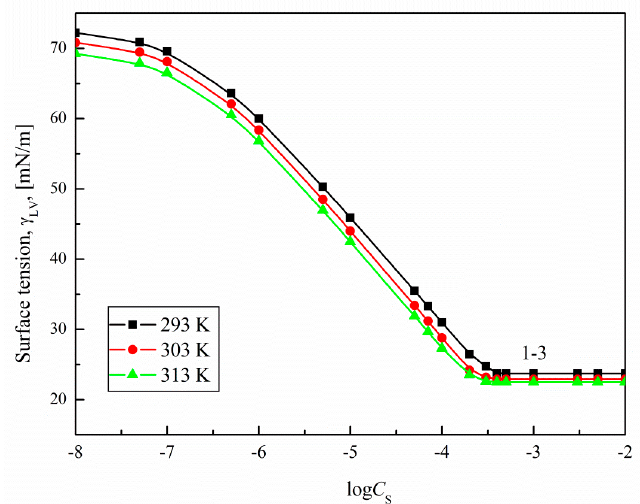
Figure 10. Measured values of surface tension ( γ LV ) of aqueous solutions of TS-OE12 (curves 1–3) at 298 K, 303 K and 313 K vs. the logarithm of surfactant concentration (log C S ). As follows from this figure, at all studied temperatures, the surface tension of the studied trisiloxane surfactant aqueous solutions decreases with increasing surfactant concentration ( C S ). It is similar as in the case of classical hydrocarbon surfactants as well as some others. In addition the surface tension of aqueous solutions of TS-EO12 depends quite strongly on temperature and increases with decreasing temperature. These results are in a good agreement with the data presented